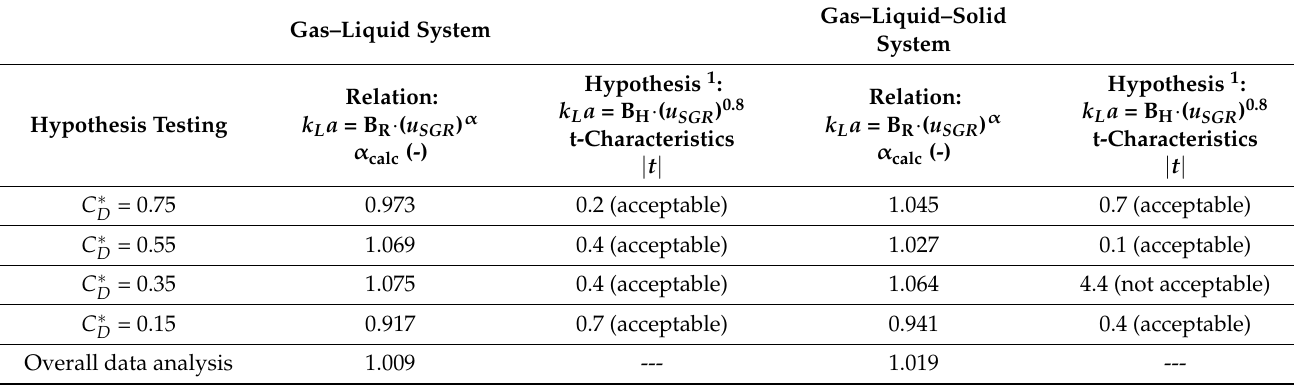
Table 14. Overall volumetric mass transfer coefficient k L a : Results of the hypothesis testing-effect of riser superficial velocity u SGR for deflector clearance C ∗ = const. D